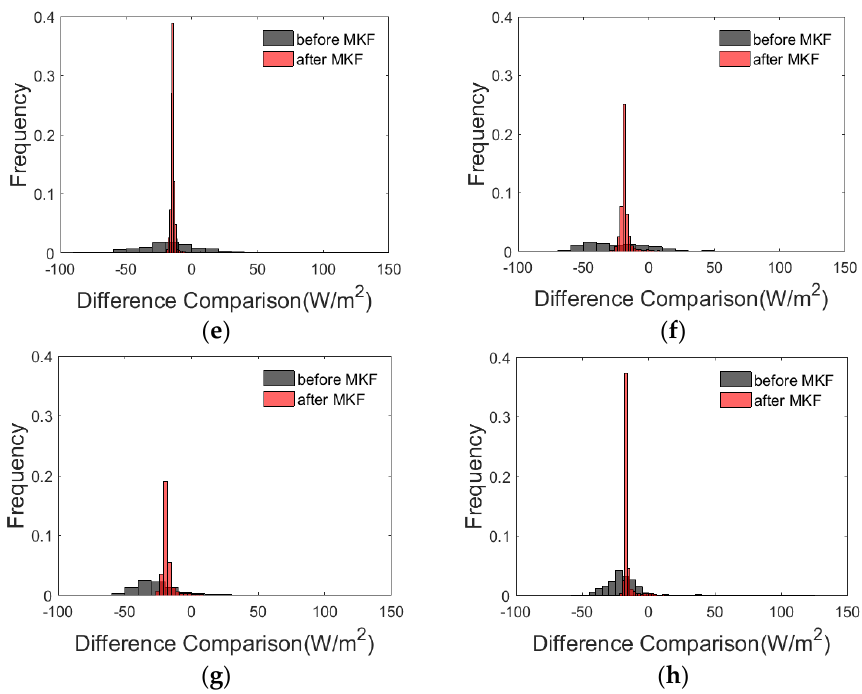
Figure 5. Comparison of the integration difference between the aggregated Landsat and MOD16 before and after MKF on time series. ( a ) DOY 177; ( b ) DOY 185; ( c ) DOY 193; ( d ) DOY 217; ( e ) DOY 225; ( f ) DOY 233; ( g ) DOY 241; ( h ) DOY 249.